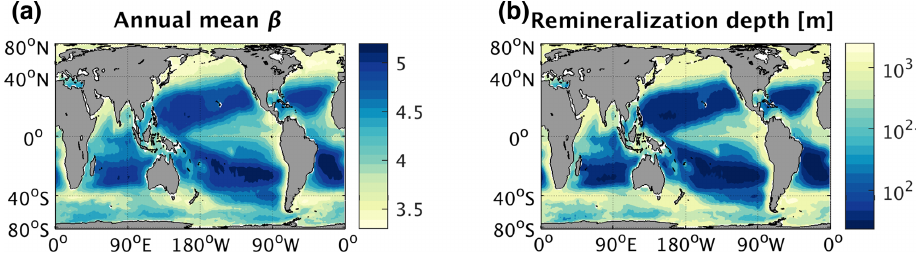
Figure 1. Global maps of annual mean (a) particle size distribution slope ( β ) measured by remotely sensed particulate backscatter and reproduced from Kostadinov et al. (2009) and (b) remineralization depth, defined as the depth at which particulate flux out of the euphotic zone is decreased by a factor of e assuming β in (a) at the surface, calculated using a particle remineralization and sinking model (PRiSM, described in Sect. 2.1.1). Larger values of β are associated with smaller particles, while smaller values of β are associated with